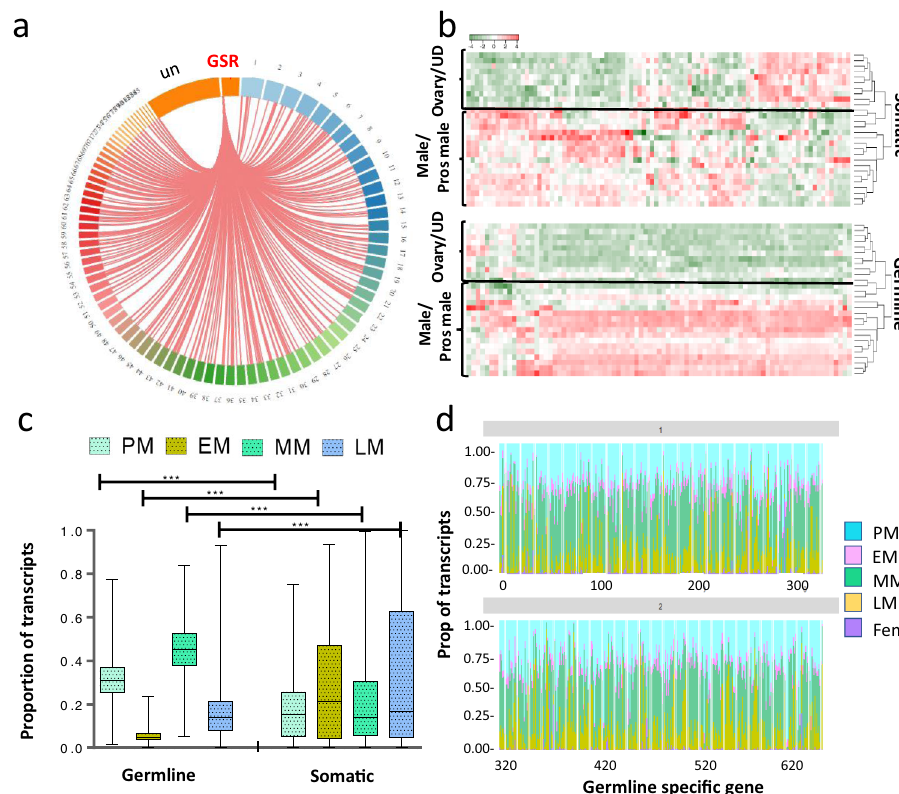
Fig. 2 Somatic paralogs of GSGs are expressed differently than germline paralogs. a Circos plot indicating the link between genes in the GSR with putative somatic paralogs in the sea lamprey genome. Chromosome 81 and enriched scaffolds are indicated as GSR and non-enriched scaffolds are indicated as un (unplaced scaffolds in somatic genome). b Heatmap showing the relative expression of genes that have paralogs in both the GSR and somatic genomes in males and prospective males (pros male), females (ovary), and undifferentiated larvae (UD). c Box plot showing the gene expression differences of somatic and GSR paralogs of GSGs in prospective males (PM), and early, mid, and late males (EM, MM, and LM, respectively). d Proportion of the transcripts for each of the 638 GSGs expressed in prospective, early, mid, and late males (PM, EM, MM, LM) and females